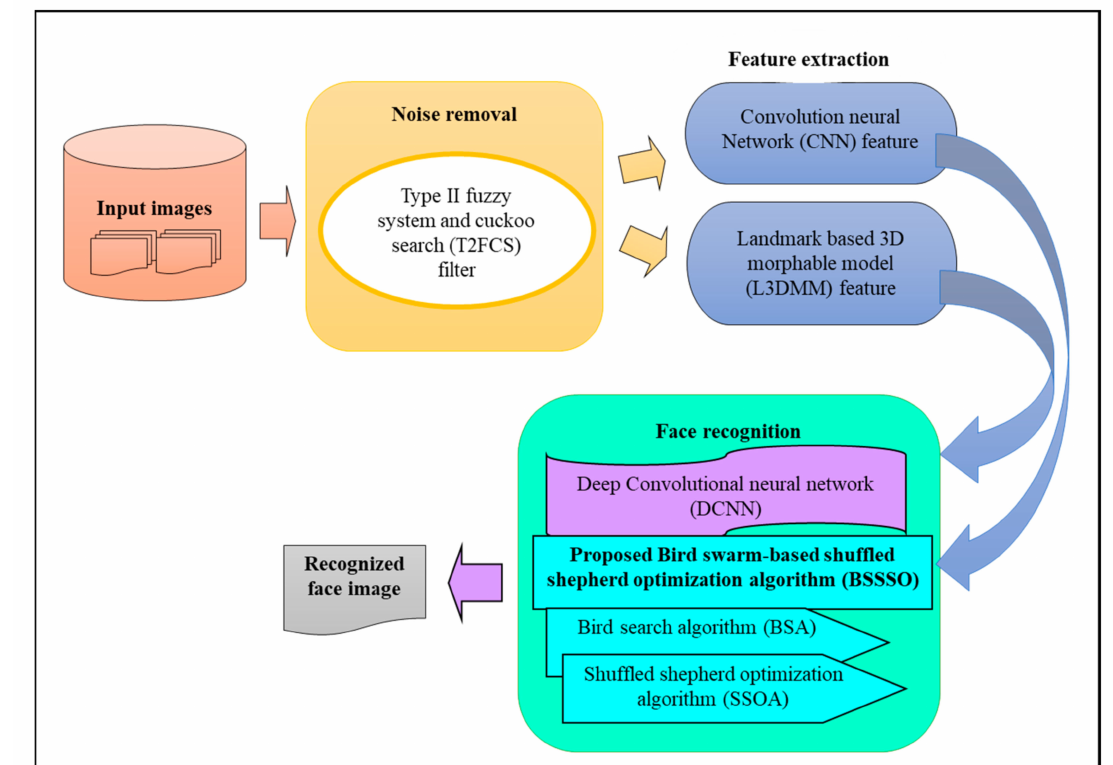
Figure 1. Schematic view of the proposed methodology of face recognition Initially, the input image undergoes a noise removal phase to eliminate noise to make them suitable for subsequent processing. The noise removal is performed using T2FCS [22], which helps to detect noisy pixels from the image for improved processing. After the noise removal phase, the feature extraction is carried out using the convolution neural network (CNN) model and L3DMM [23]. Here, the CNN is a multi-layered neural network with a special architecture for detecting the complex features in the data and the L3DMM feature is utilized to fit a 3D face from the single uncontrolled image. The obtained features are subjected to Deep CNN for face recognition. The training of the deep neural network is performed using the bird search-based shuffled shepherd optimization algorithm (BSSSO). algorithm (SSOA) [16] and bird swarm algorithm (BSA) [17] for training Deep CNN.